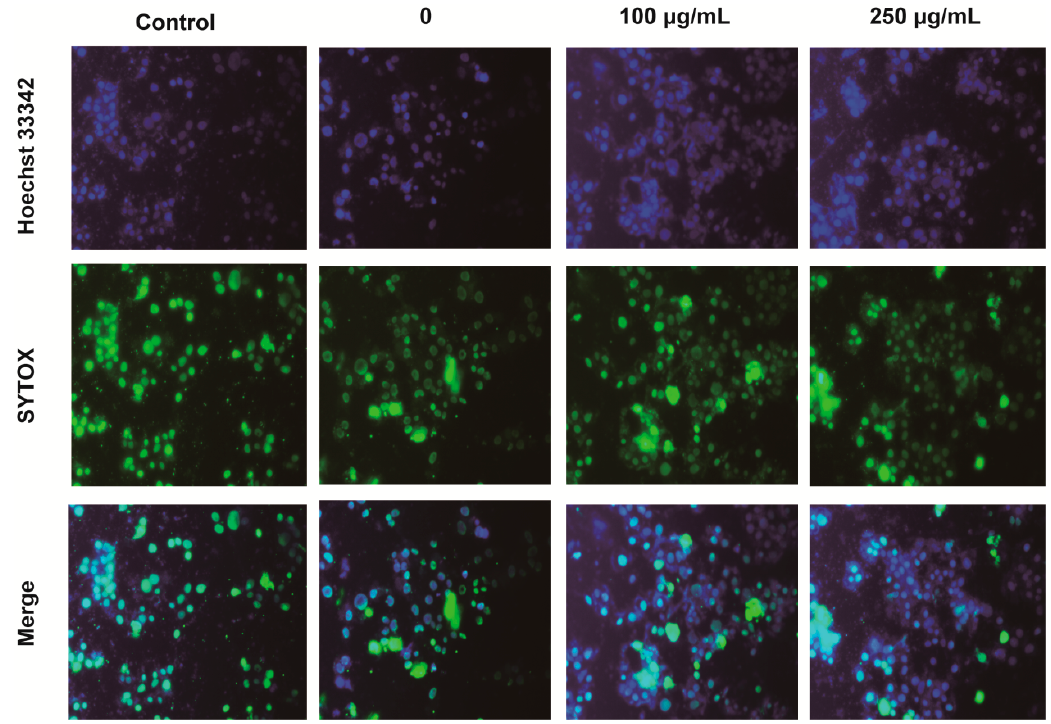
Figure 3. Fluorescence micrographs of PC12 cells stained with Hoechst 33342 and SYTOX green staining (original magnification, ×100).